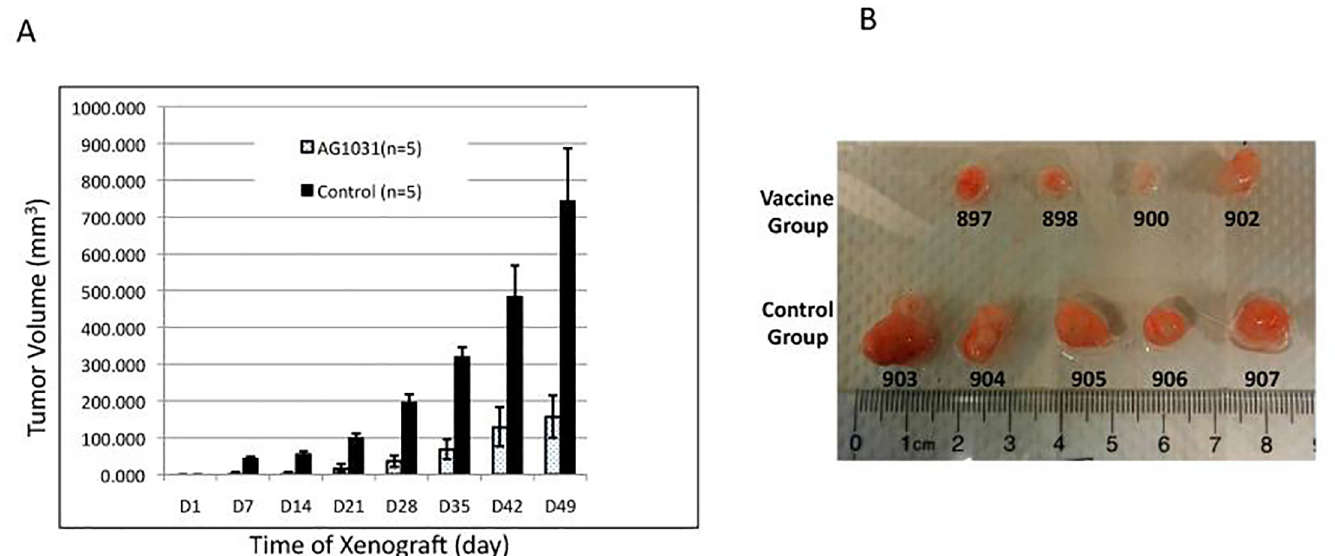
Fig 6. Pre-treatment with AG-1031 prevents tumor development. AG-1031 was pre-injected (IP) into mice once a week for 3 weeks before they were inoculated with A549 cells. (A) The tumor size of both treated (AG-1031) and untreated (Control) groups was measured and the average tumor size was compared. (B) Tumors from both groups were dissected on day 49, and individual tumors from each group are shown. Since one in five animals (#901) in the treated group failed to develop any tumor, even until day 49, only 4 tumors were shown in the treated